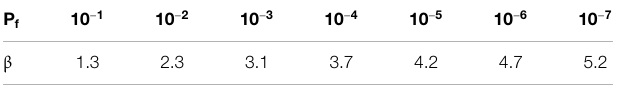
TABLE 1 | Relationship between failure probability and reliability index (Leonardo da Vinci Pilot Project,